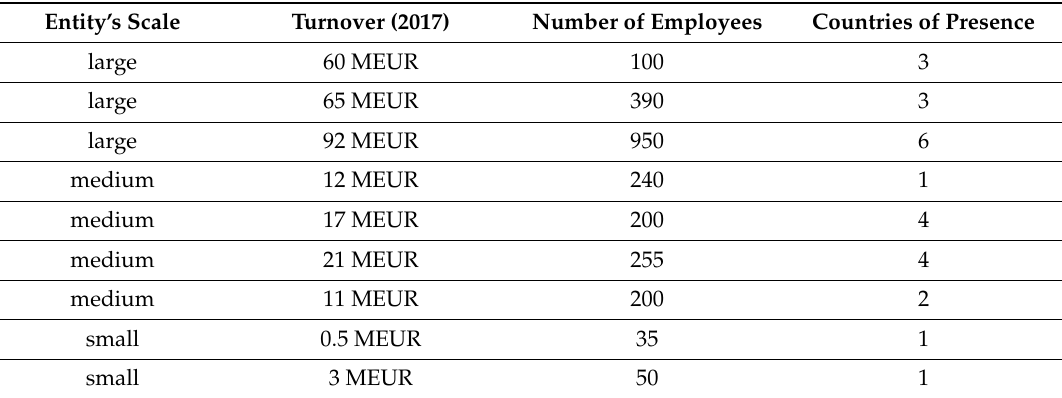
Table 4. The data of the companies whose representatives were interviewed.